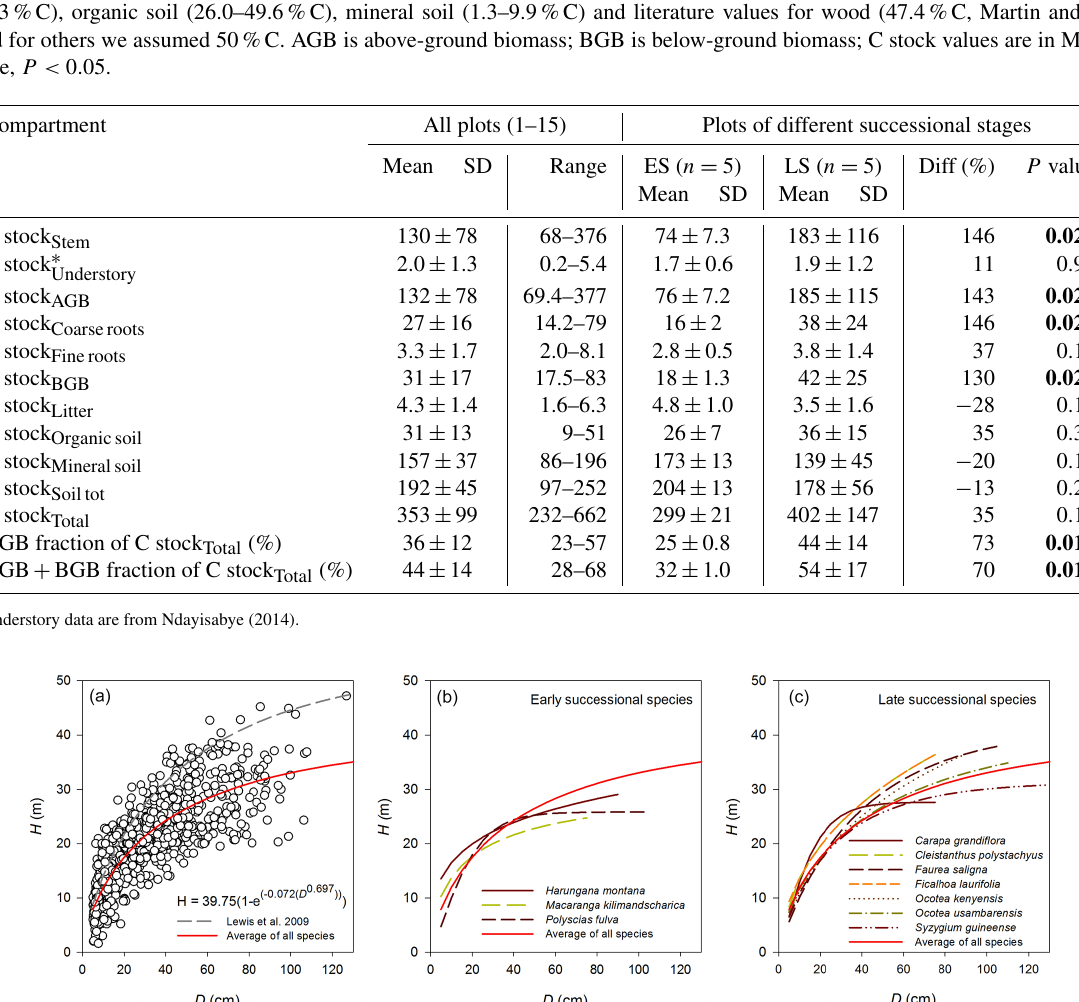
ρ of LS compared to ES plots was 29 % higher ( P < 0 .